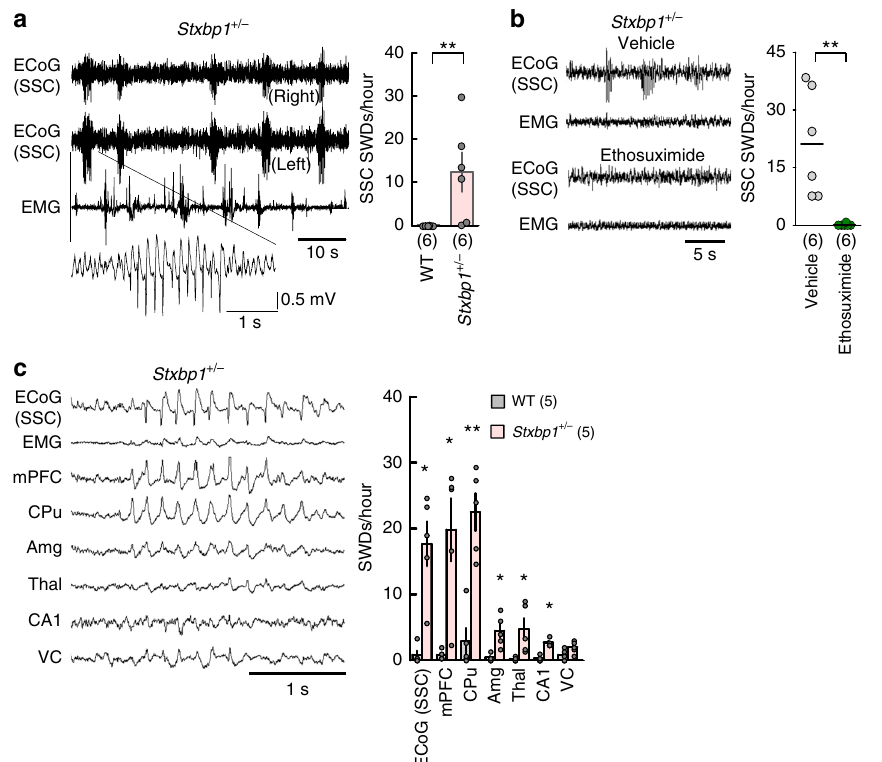
Fig. 1 Ethosuximide-sensitive SWDs predominantly appear in the SSC, mPFC and CPu of Stxbp1 + / − mice. a SSC SWDs in Stxbp1 + / − mice. (Left) Bilateral ECoG and electromyogram (EMG) recordings in an Stxbp1 + / − mouse. (Right) Number of SWDs (24 h recordings). WT ( N = 6) and Stxbp1 + / − mice ( N = 6) (Mann – Whitney U test; ** P = 0.0047). b Ethosuximide ef fi ciently suppressed SWDs. (Left) Representative recordings. (Right) Number of SWDs (2.5